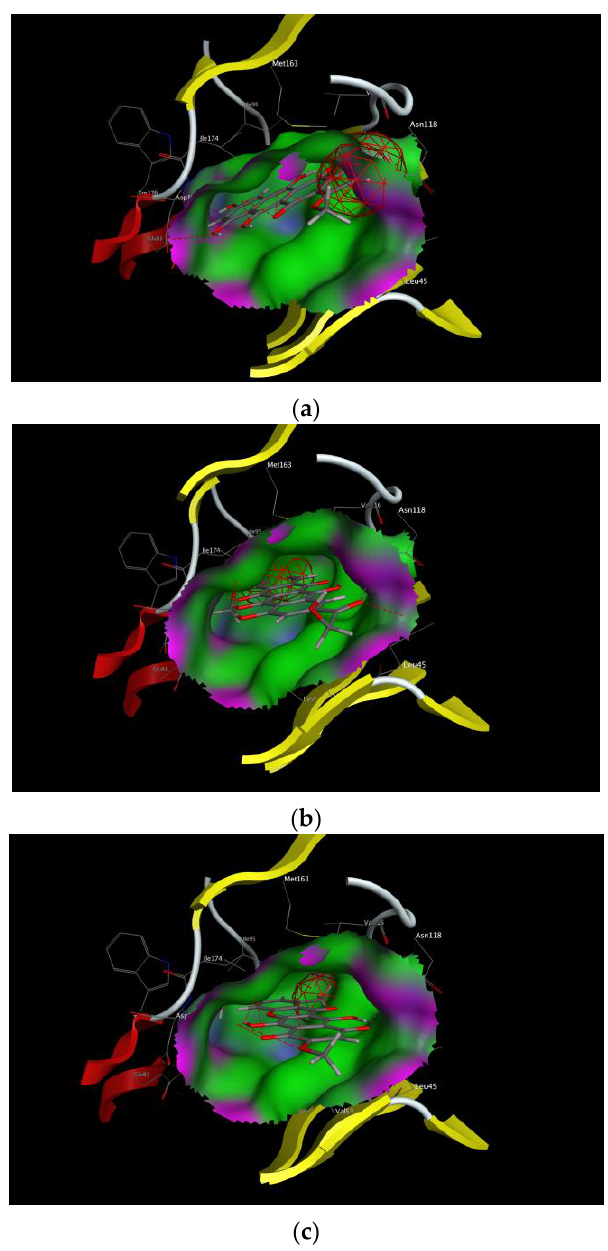
Figure 4. Binding mode of the selected ligands with the binding site of CK2. ( a ) ZINC35643753; ( b ) ZINC44136135; ( c ) ZINC05765165.